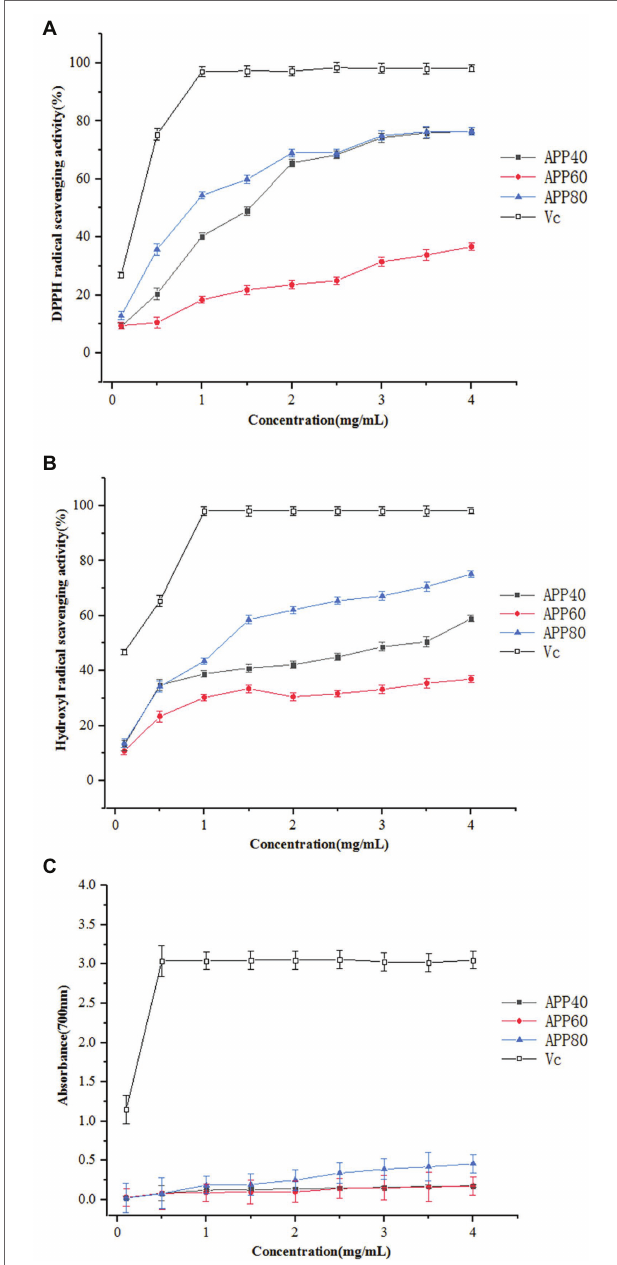
FIGURE 9 | Antioxidant activity of polysaccharides. (A) DPPH radical scavenging activity; (B) hydroxyl radical scavenging activity; and (C) reducing